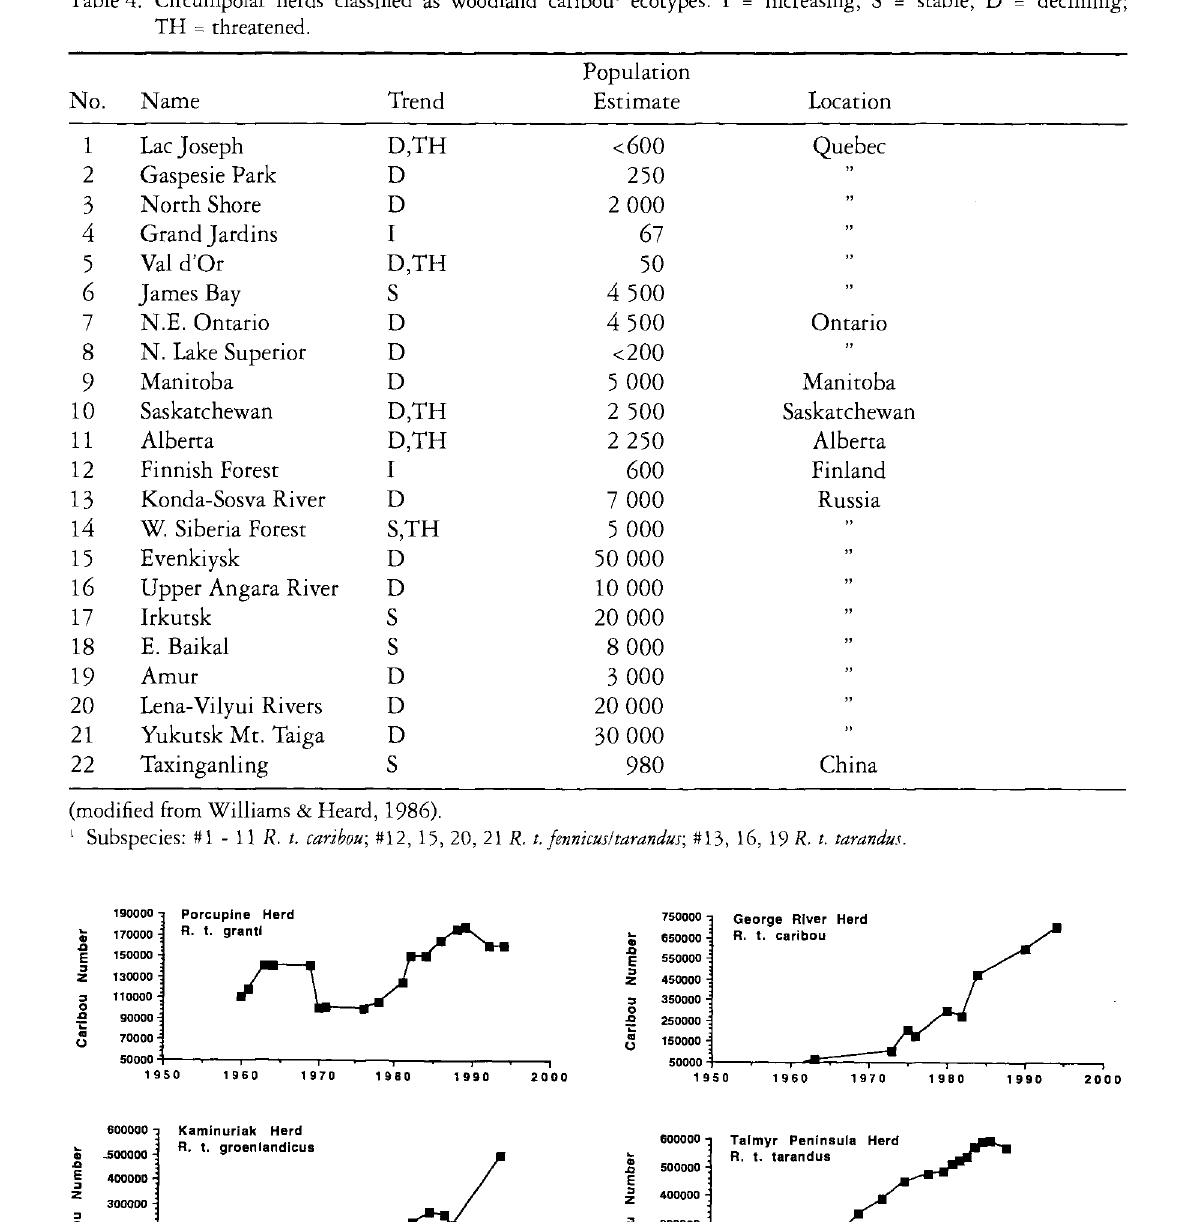
Table 4. Circumpolat herds classified as woodland caribou' ecotypes: I = increasing; S = stable; D = declining; TH = threatened.